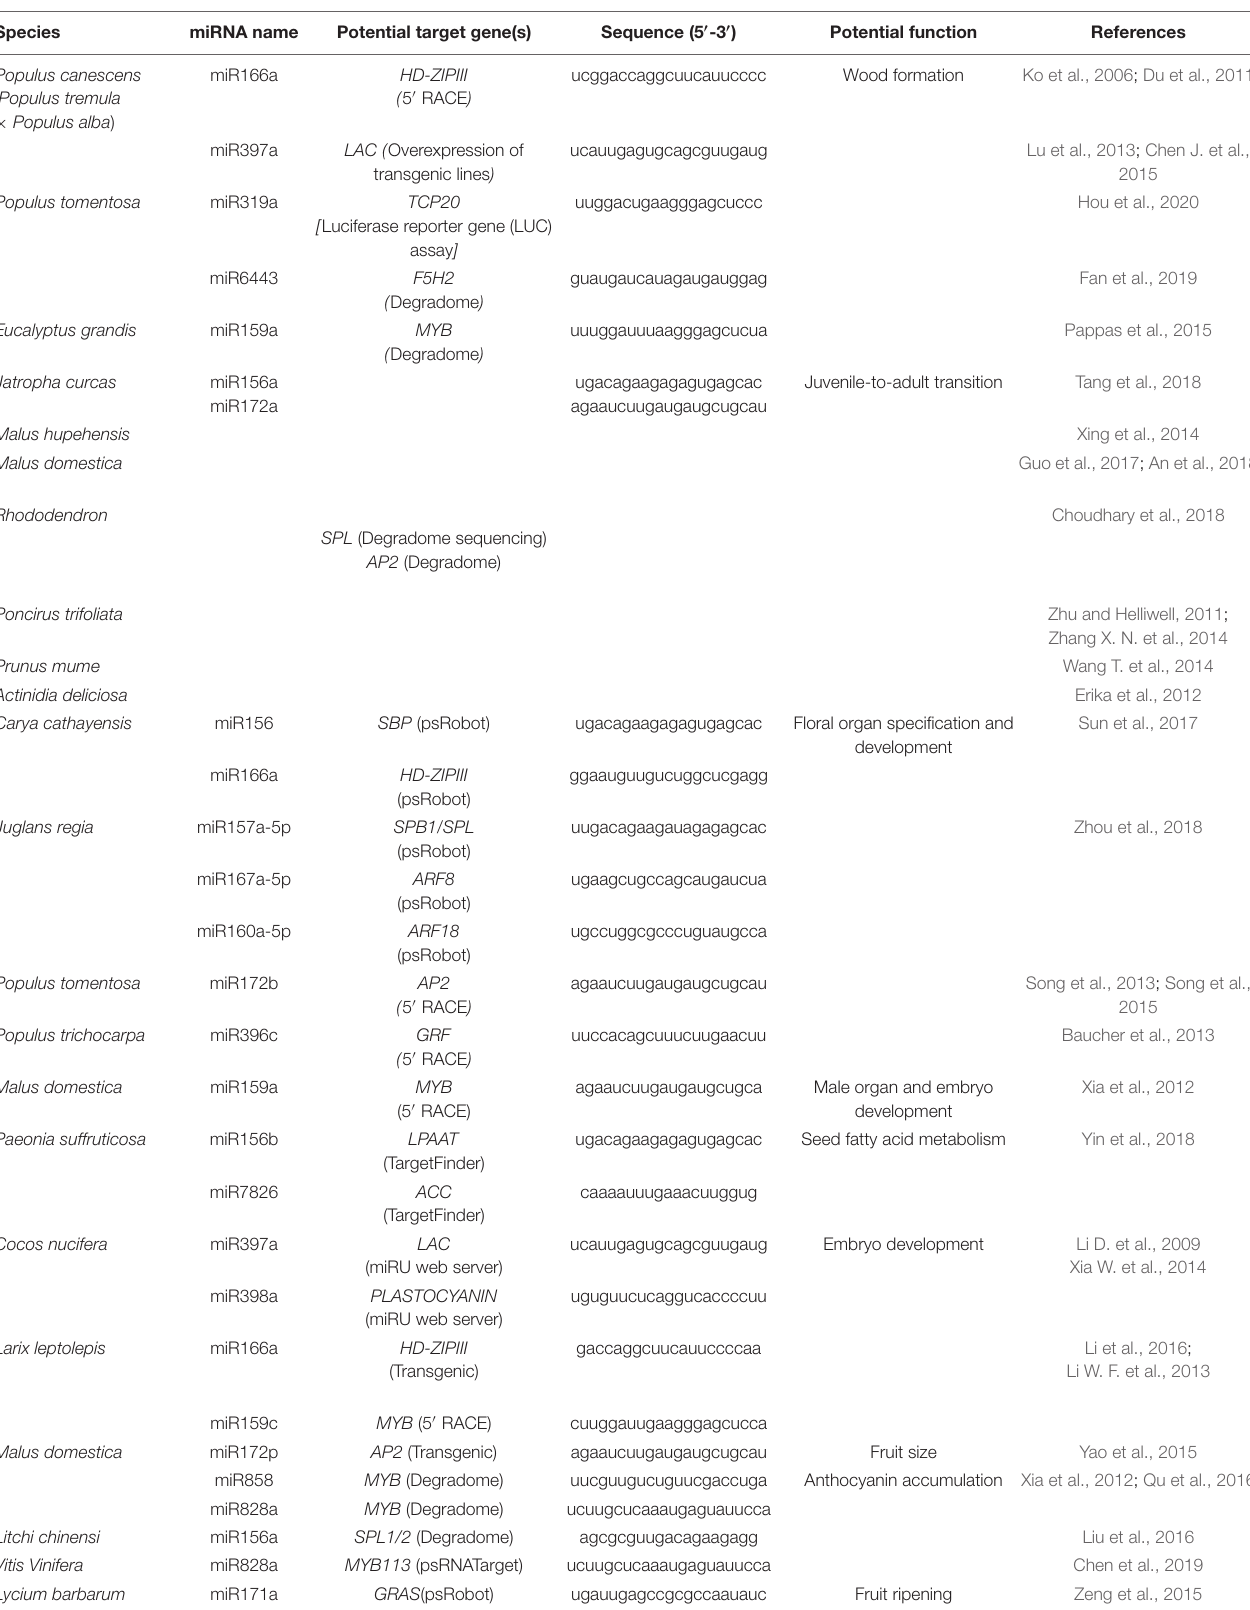
TABLE 2 | MiRNAs are involved in the growth and development of